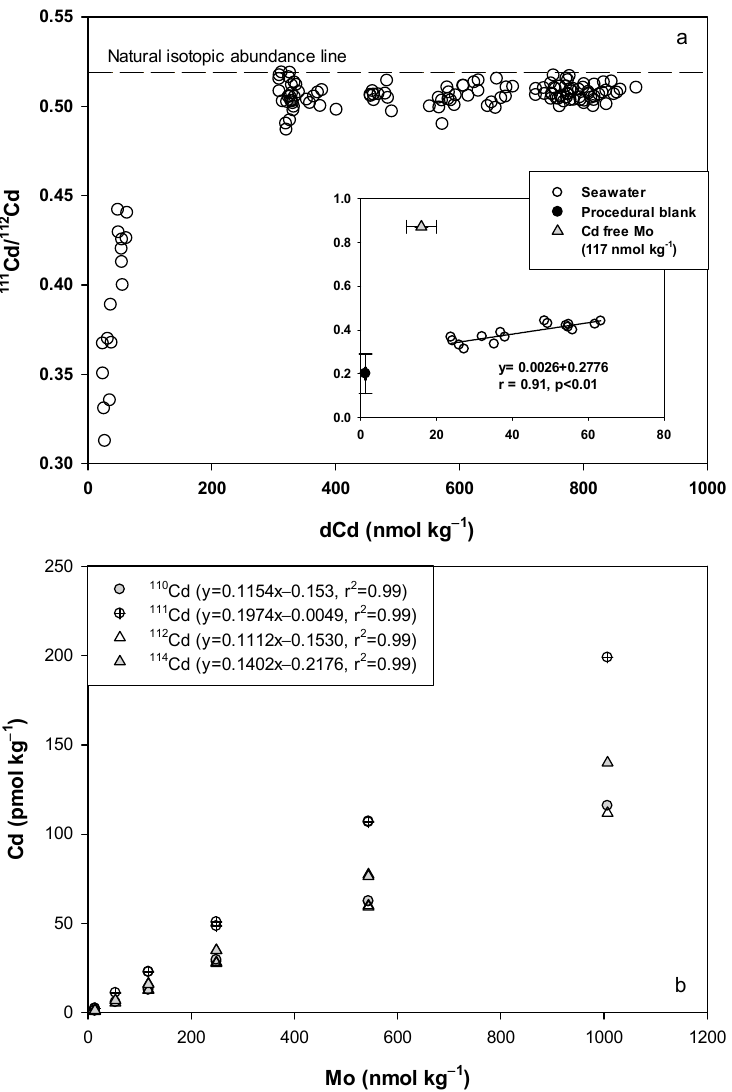
Figure 3. ( a ) Measured 111 Cd/ 112 Cd ratios for a wide range of seawater Cd concentration. ( b ) MoO + -derived Cd concentrations are shown with a range of mono-element Mo solutions.